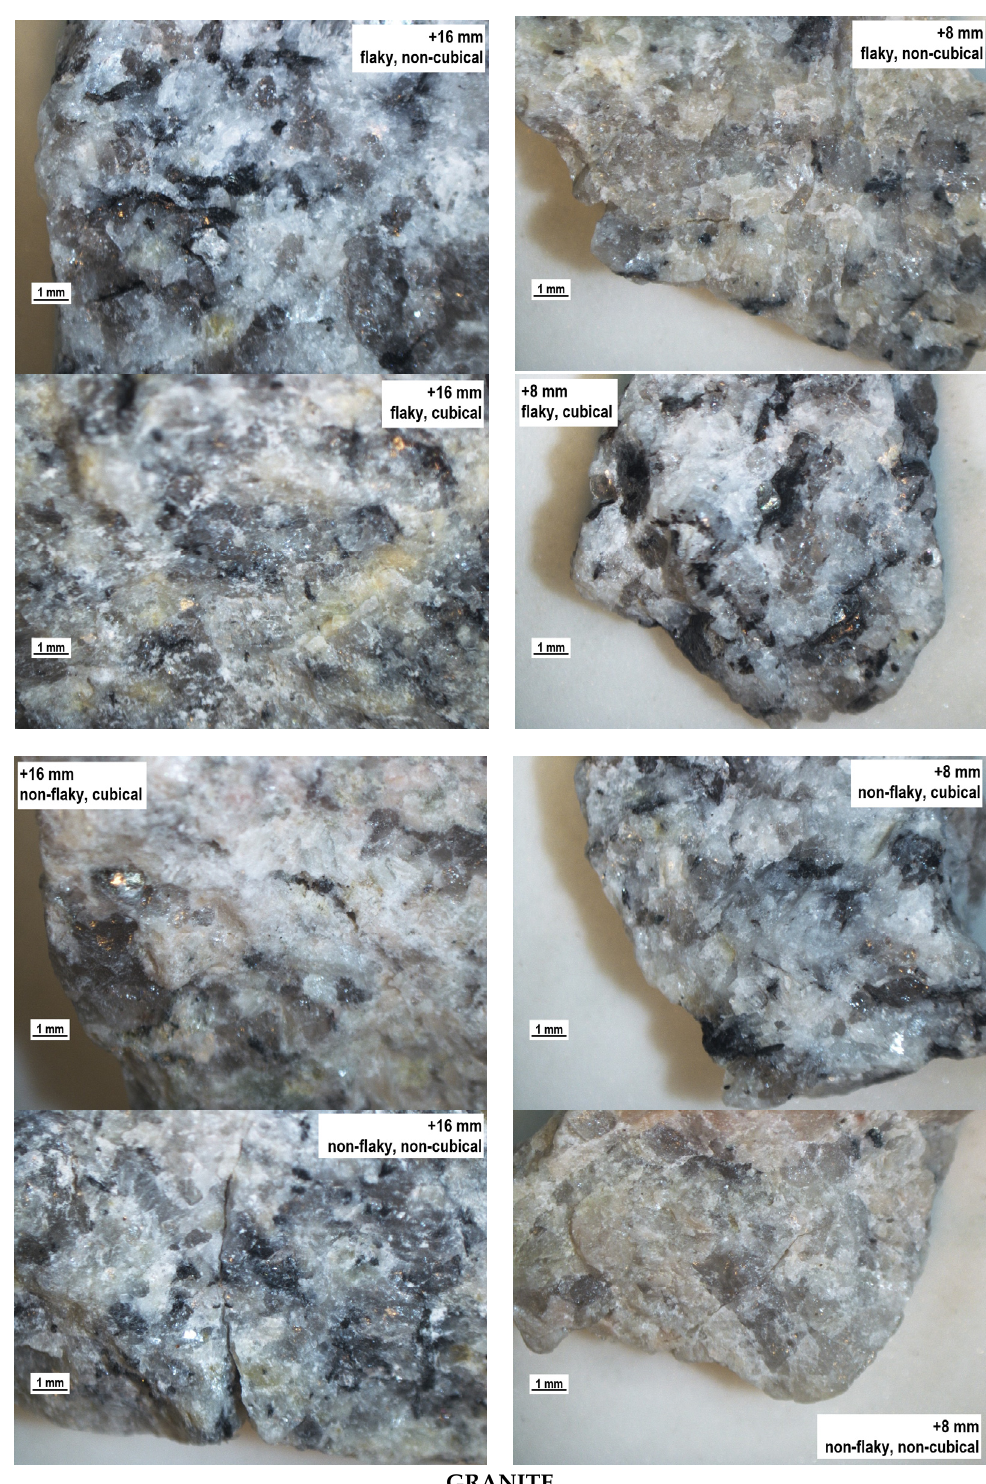
Figure 8. The structure of the particles of the basalt 2 aggregate, separate for the shape and particle size. The granite aggregate (Figure 9) has a low content of fractures in both of the analyzed size fractions. The fractures were mainly related to the structure of the mica minerals. The flaky thin particles were observed to be more prone to fractures.